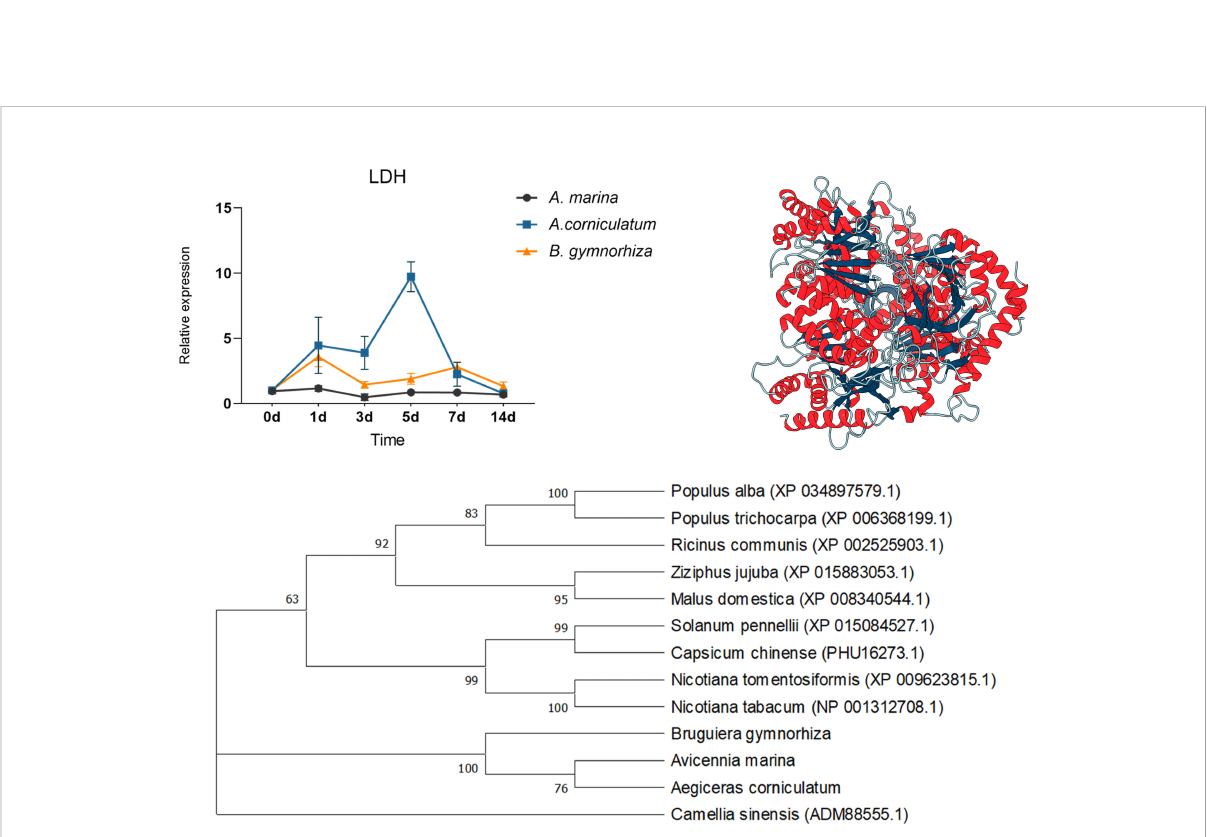
FIGURE 9 Quantitative expression of LDH s in three mangrove plants, 3D structure of AcLDH, and phylogenetic tree of